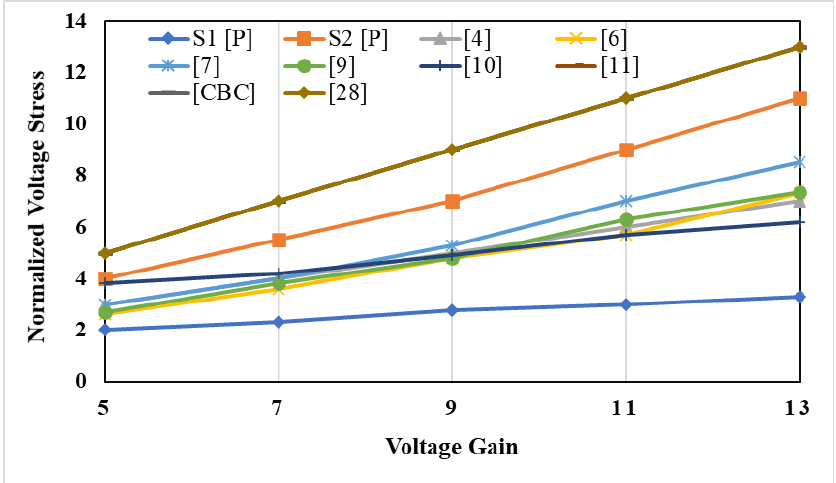
Figure 6. Comparison of stress across the switches.